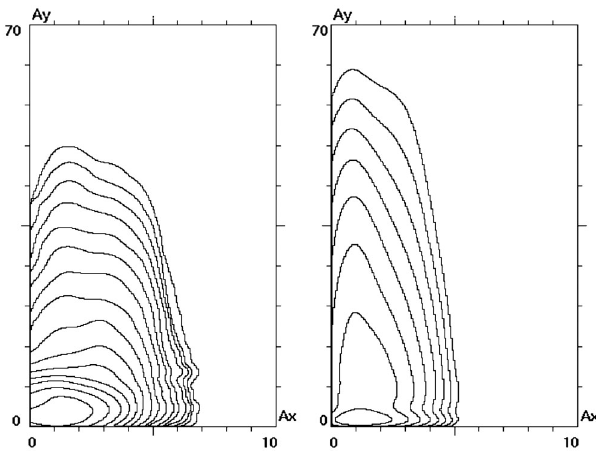
FIG. 3. Equilibrium beam distribution in the plane of normal- ized betatron amplitudes for TLEPZ. Left is without beamstrah- lung, right is with beamstrahlung. The density between successive contour lines drops by a factor of e .